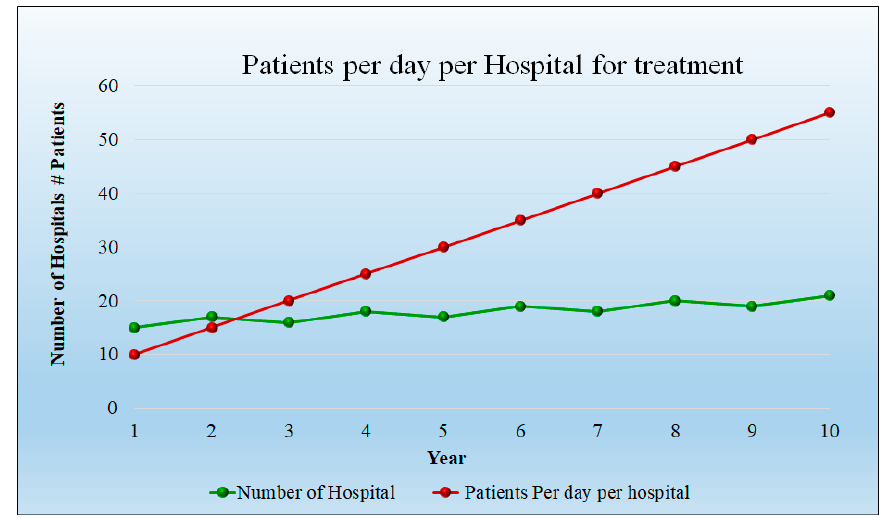
Figure 13. Patients per day per Hospital for treatment (red), number of hospitals (green).